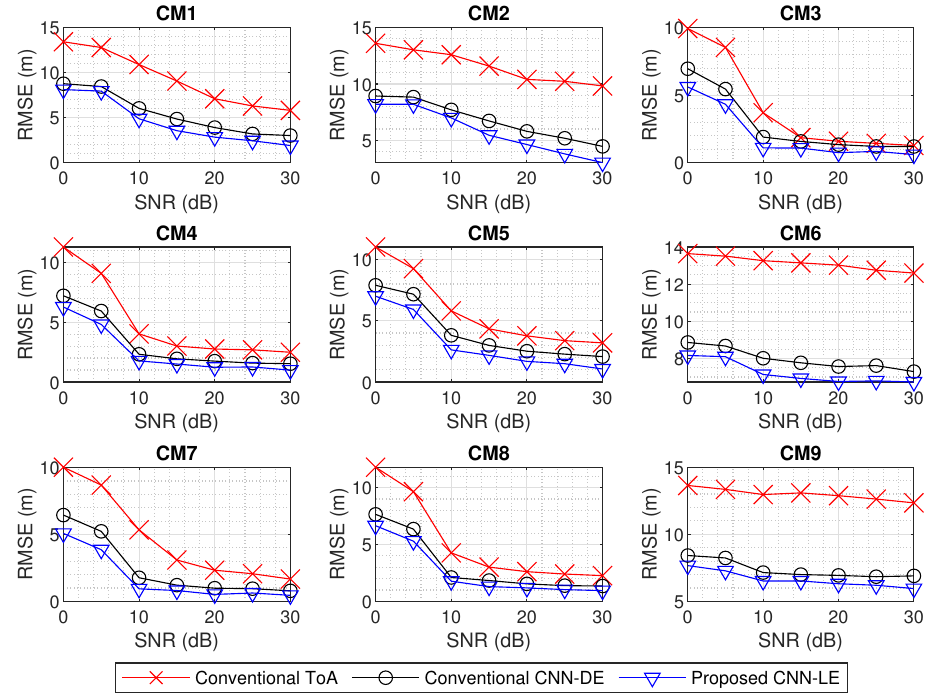
Figure 6. RMSE ( y -axis) performance across SNR ( x -axis). CM# data is used for both training and